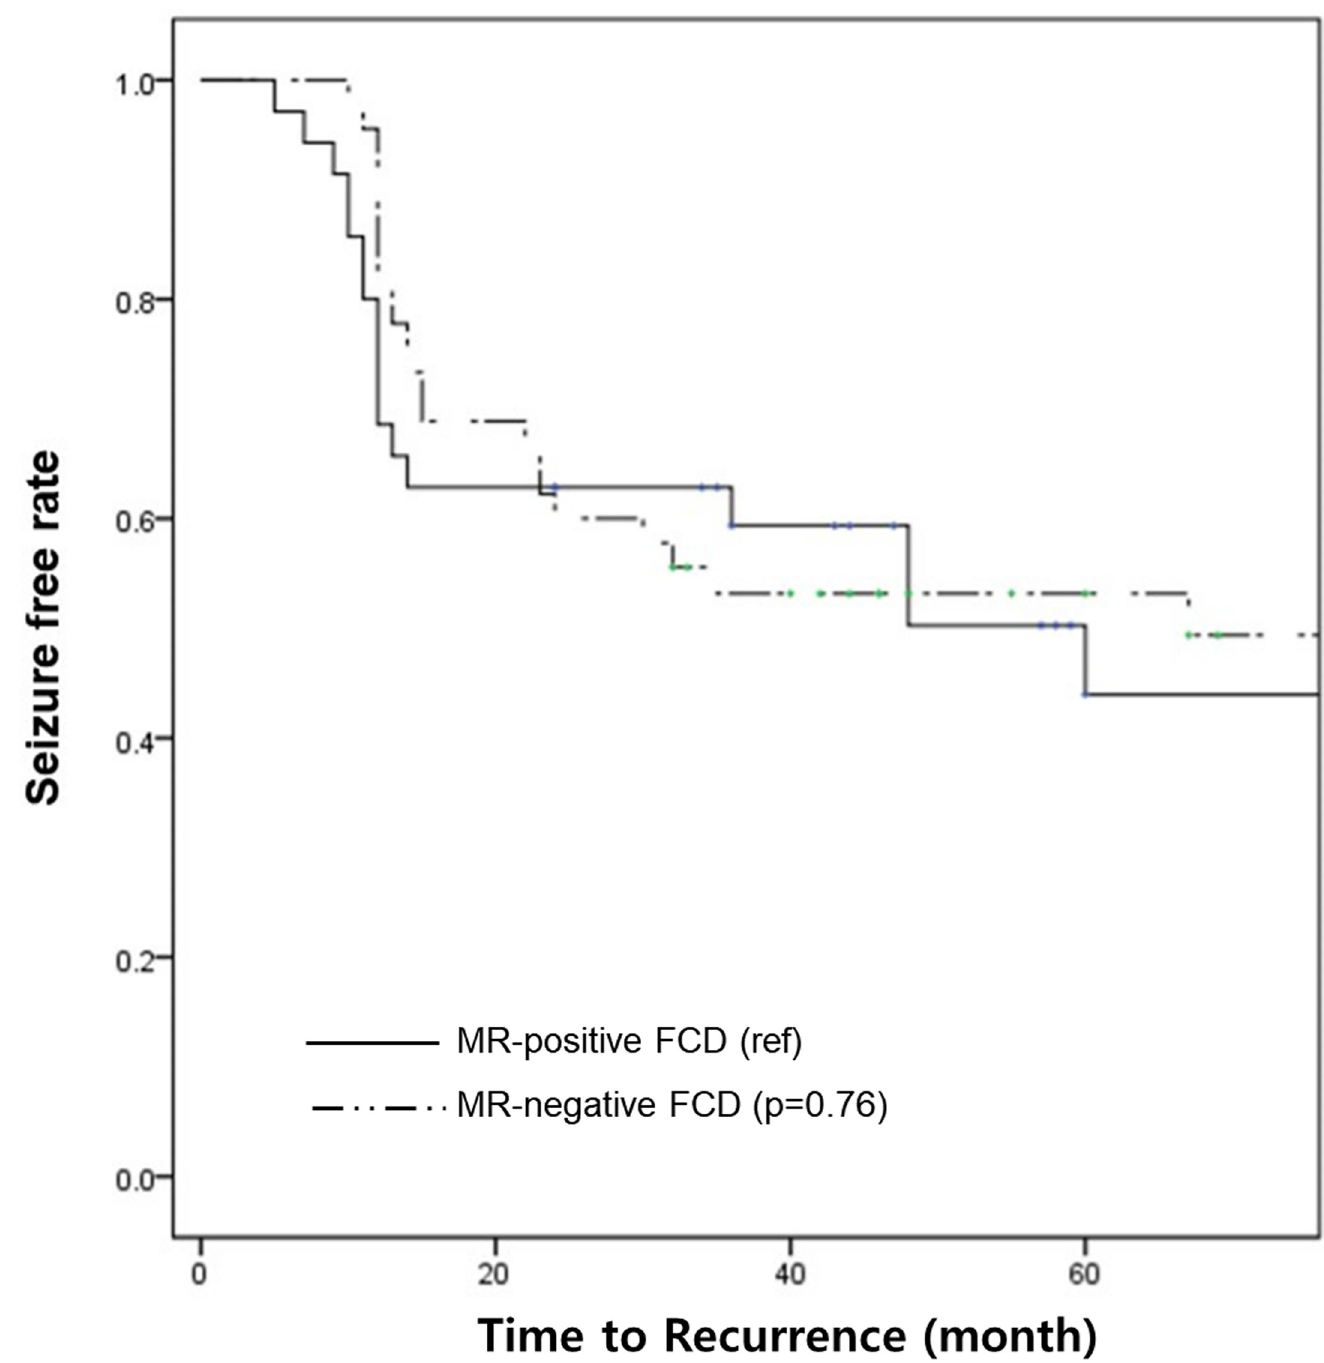
Fig 2. Kaplan-Meier survival curves according to MRI findings. The survival curves showed no statistical significance between the MR-positive FCD and MR- negative FCD groups (solid line: MR-positive FCD, dashed line: MR-negative FCD).